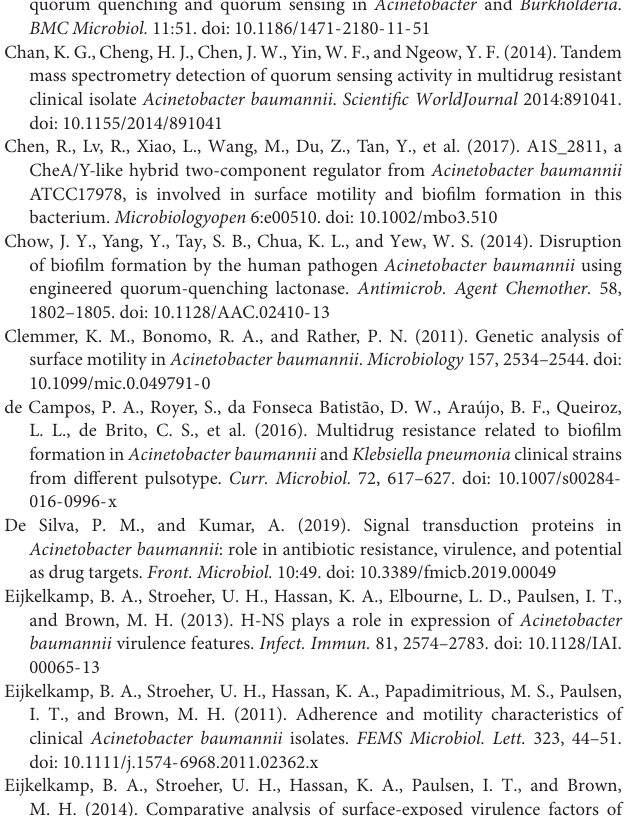
Supplementary Figure 1 | Effect of culture media composition and type of agar on surface-associated motility of A. baumannii ATCC17978, A. nosocomialis M2 and their respective mutants of the AbaI AHL-synthase. LB and Low Salt-Low Nutrient LB (LSLN-LB 0.5% NaCl, 0.2% tryptone, and 0.1% yeast extract) were tested. Eiken or Difco agar were added at 0.25%. Plates were incubated at 37 ◦ C for 14 h, and they are representative of three independent experiments carried out with three replicates per condition. Supplementary Figure 2 | Effect of the components of LB culture medium on the motility of A. nosocomialis M2 and its abaI:Km mutant. 0.25% Eiken agar